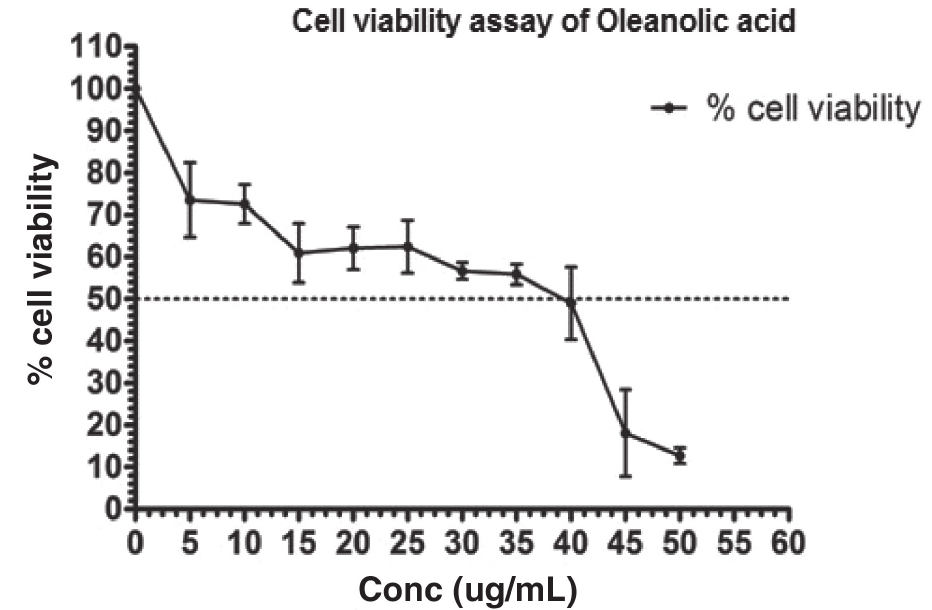
FIGURE 4 - Anti-proliferative efficacy of oleanolic acid against HCT116 colon cancer